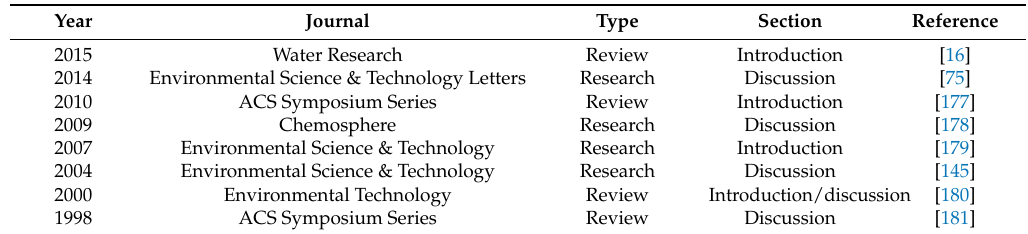
Table 3. SCOPUS chronological bibliometry of Khudenko [67] showing citation by eight (8) sources comprising four (4) review and four (4) research